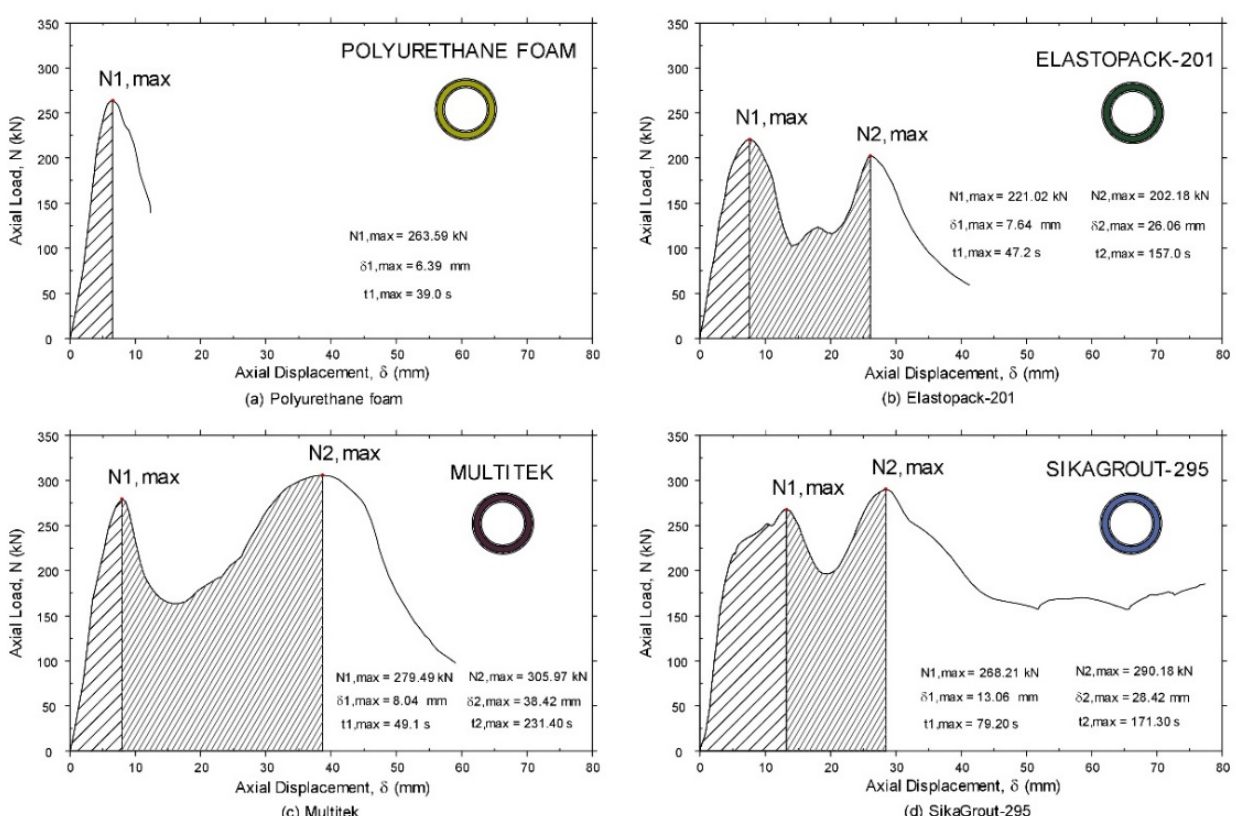
Figure 11. The strain energies of the elements represented by the area enclosed under the load-displacement curve: ( a ) Polyurethane foam, ( b ) Elastopack-201, ( c ) Multitek and ( d ) Mortar (Si- kaGrout-295).